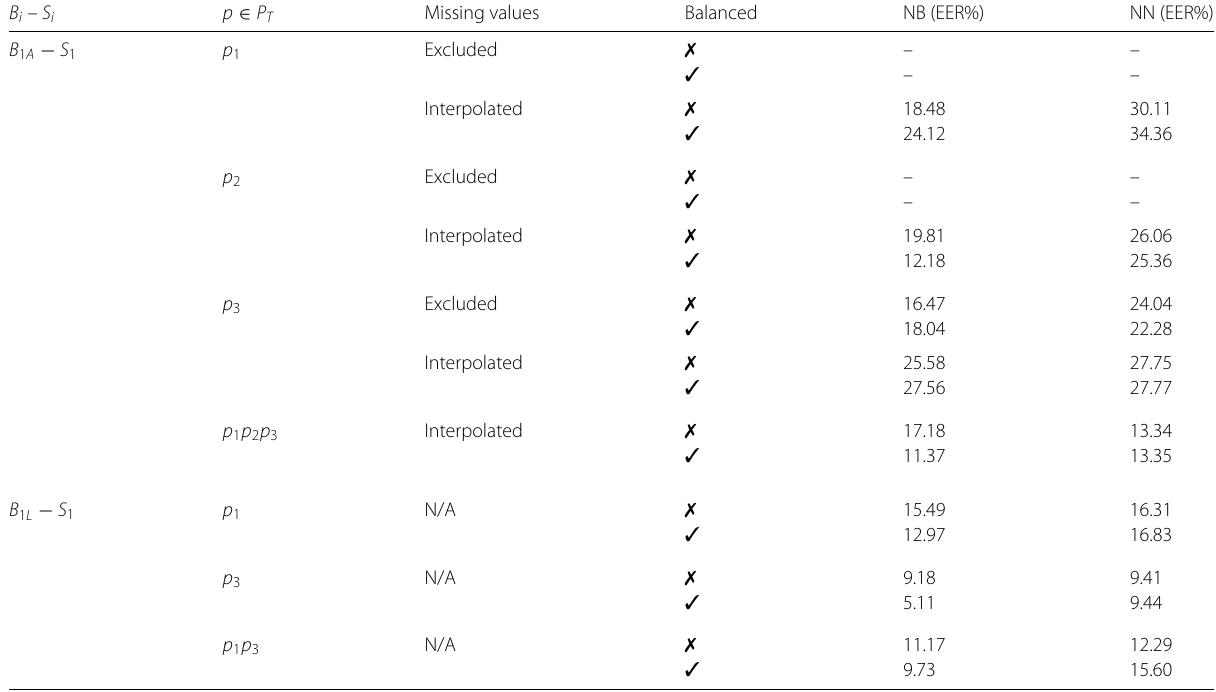
Table 5 Results for T 2.1 and T 2.2 : fivefold cross validation equal error rates (EER) for each phrase under Gaussian naive Bayes (NB) and Euclidean nearest neighbour (NN) B i – S i p ∈ P T Missing